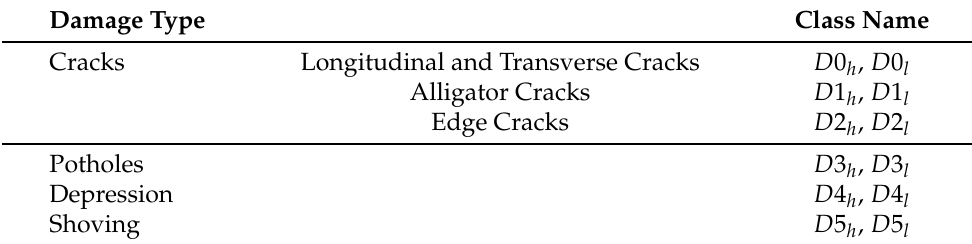
Table 3. Damage Severity.